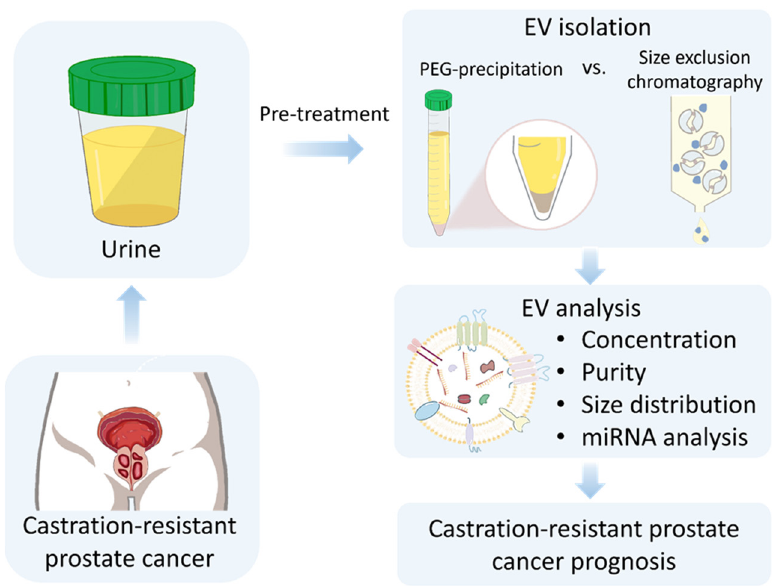
Figure 1. Schematic illustration of extracellular vesicle (EV) isolation using polyethylene glycol (PEG) precipitation or size exclusion chromatography and analysis from the urine of healthy donors and patients with CRPC.